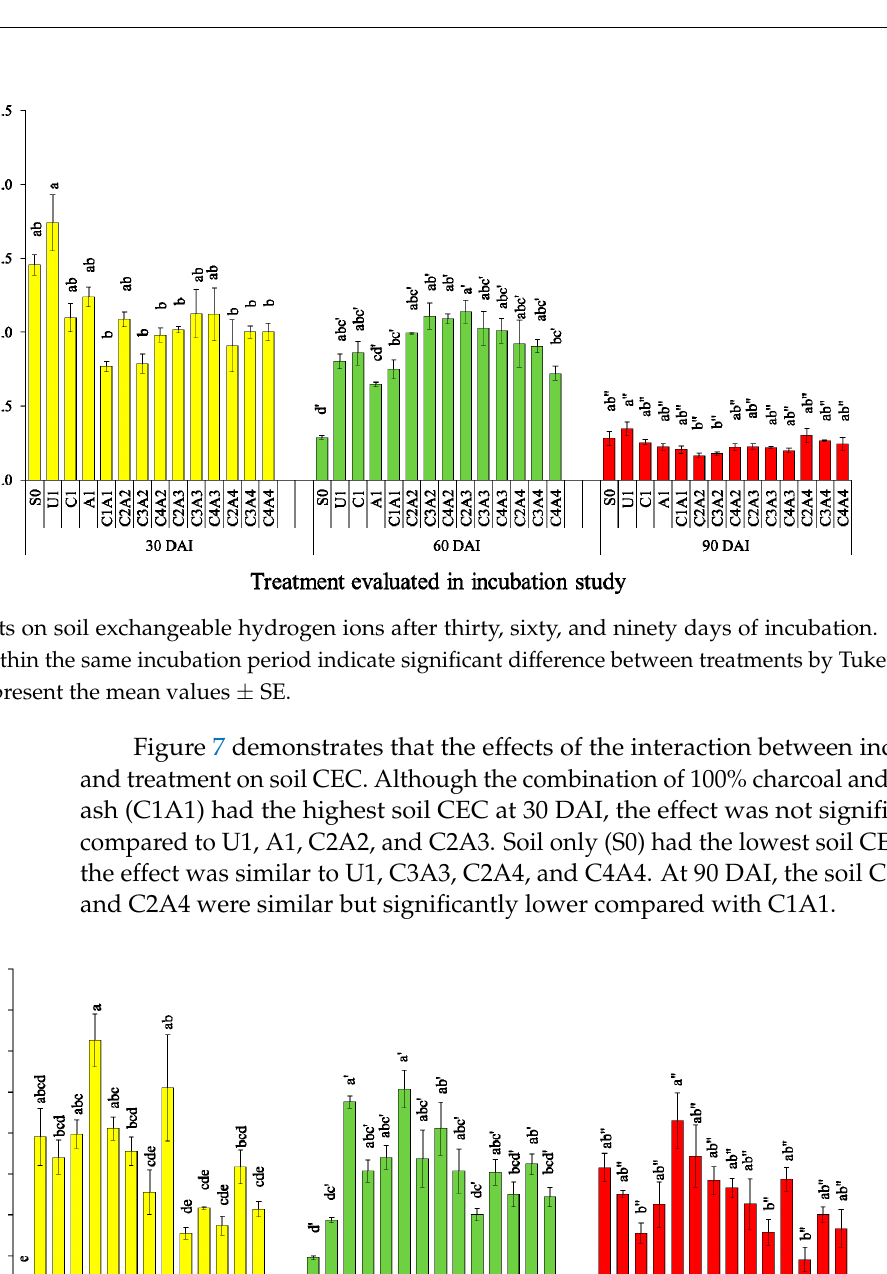
Figure 7. Treatments on soil cation exchange capacity after thirty, sixty, and ninety days of incuba- tion. Means with different letter(s) within the same incubation period indicate significant difference between treatments by Tukey ’ s HSD test at p ≤ 0.05. Bars represent the mean values ± SE.